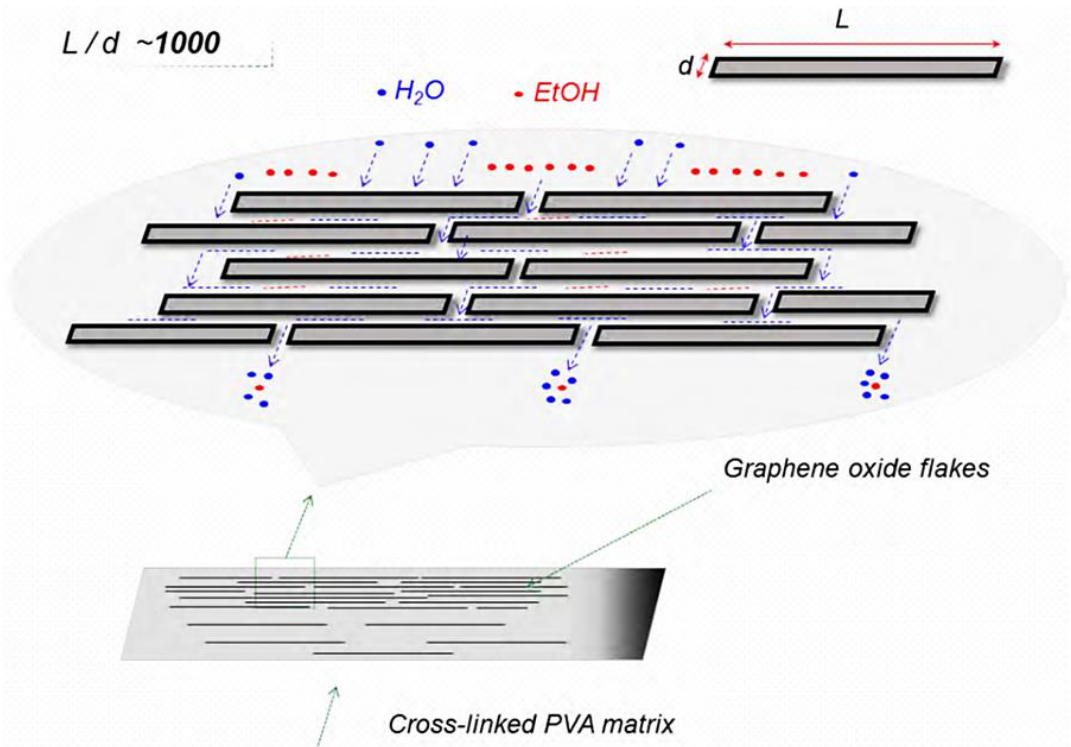
Figure 9. Schematic of water permeation mechanism through PVA/GO laminates [116]. PVA/GO — poly (vinyl alcohol)/graphene oxide. Reproduced with permission from ref. [116]. Copyright 2019 Elsevier.